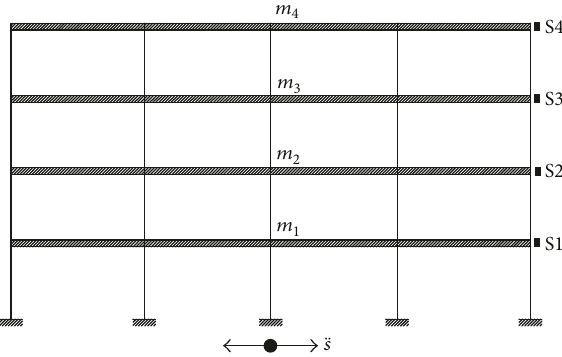
Figure 7: Shear-type frame and sensors disposition.